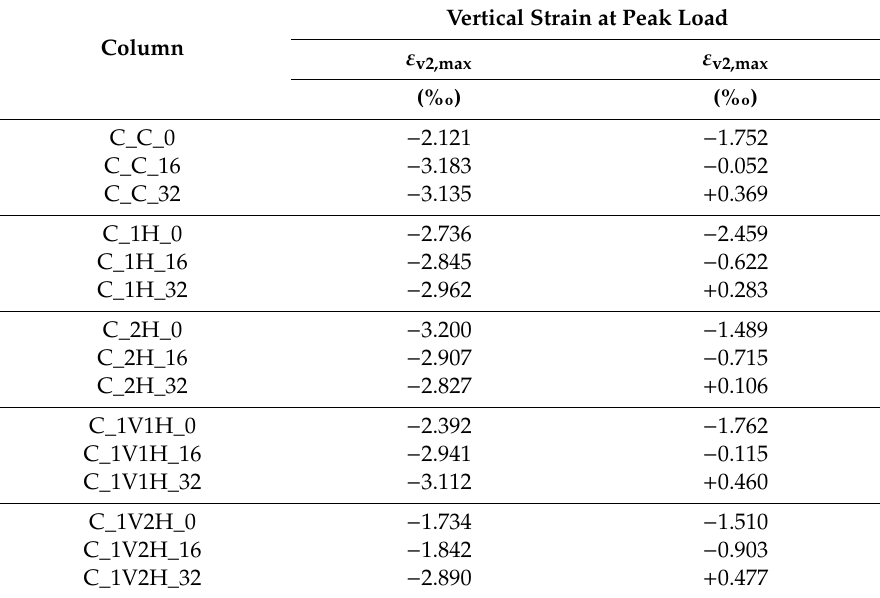
Table 4. Summary of testing results.